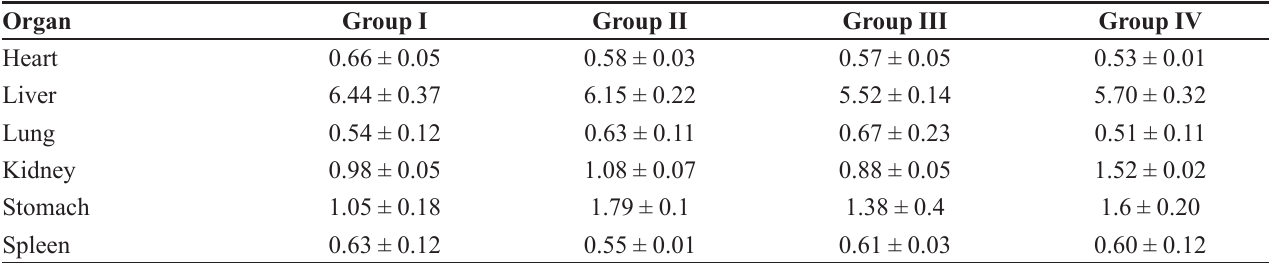
Spleen 0.63 ± 0.12 0.55 ± 0.01 0.61 ± 0.03 0.60 ± 0.12 All values are expressed as mean ±